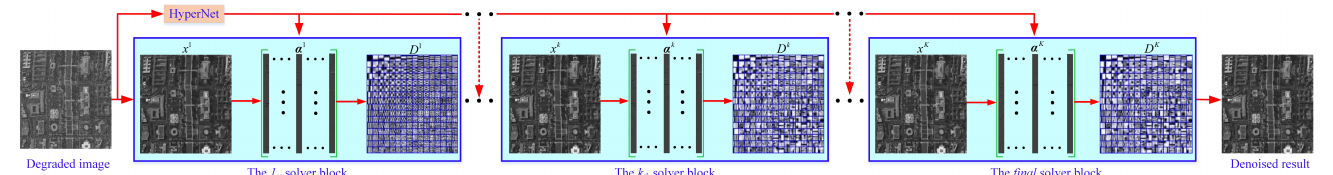
Figure 2. The flowchart of the proposed model-driven deep remotely sensed image